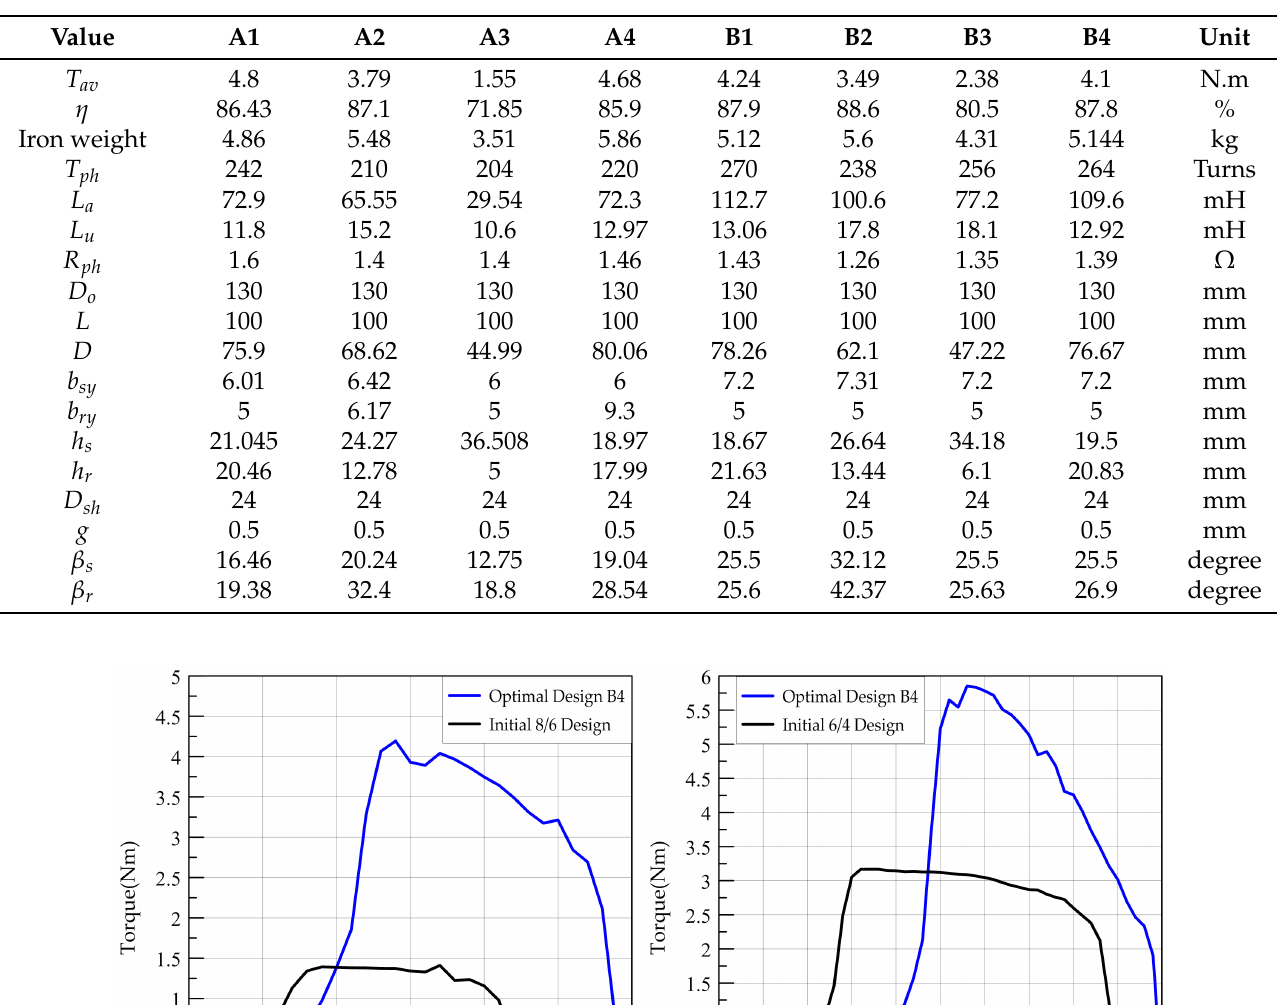
Table 4. Parameters and objective functions values of the selected optimal designs.